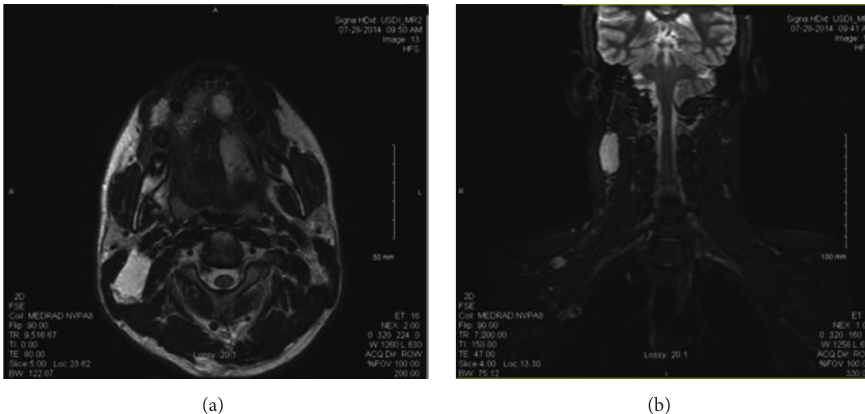
Figure 3: (a) Axial T2-weighted MRI demonstrating soft tissue masses with hyperintense signal of the left tongue and right submandibular triangle.(b)CoronalT2-weightedMRIdemonstratinghyperintenselesionsoftherightsuprahyoidposteriortriangleandrightsupraclavicular